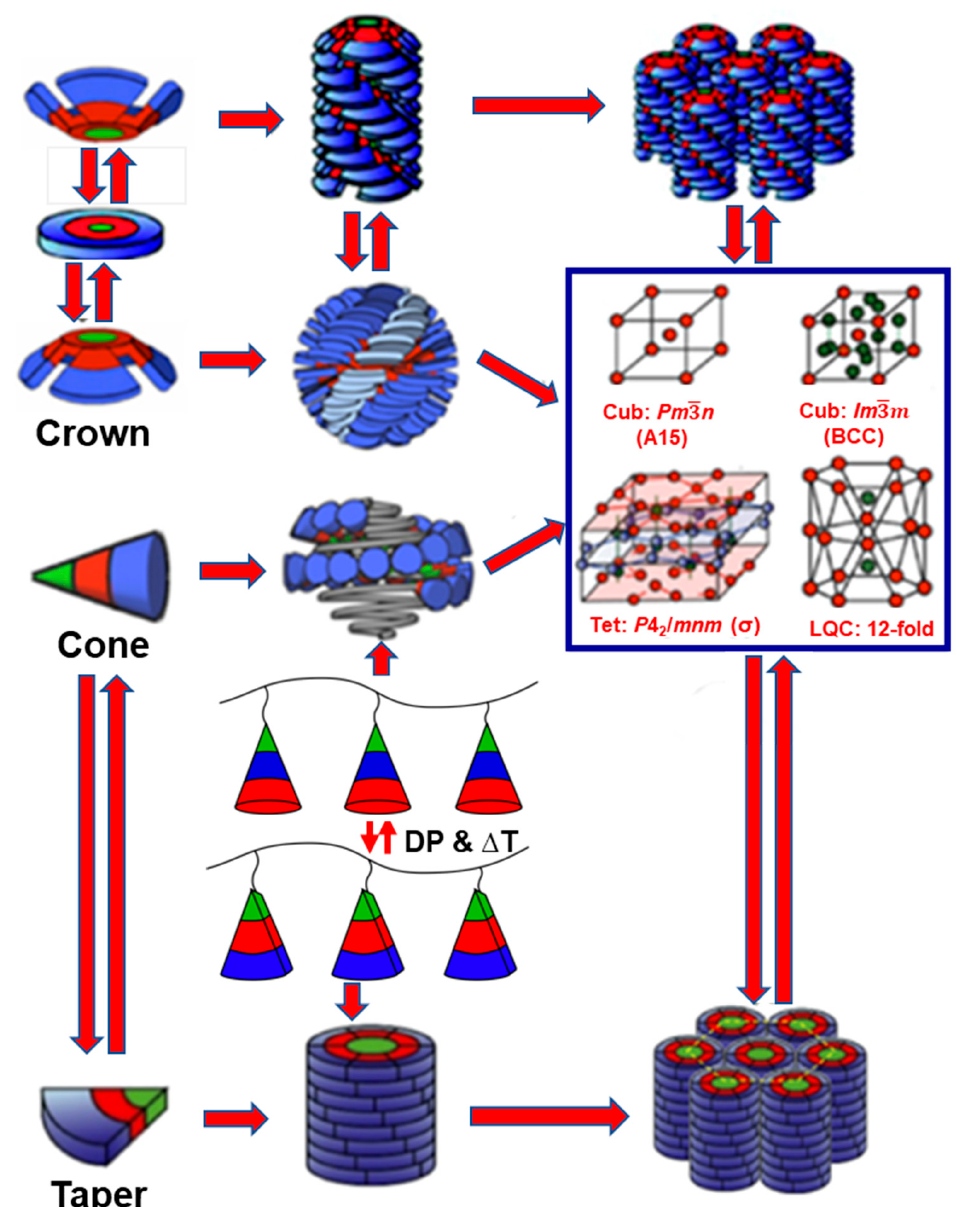
Figure 15. Self-assembly and self-organization of crown-like, cone-like and taper-like dendrons and other corresponding self-organizable dendronized polymers. Shape of secondary and tertiary structure mediated bt temperature and/or degree of polymerization of the dendronized polymer backbone.